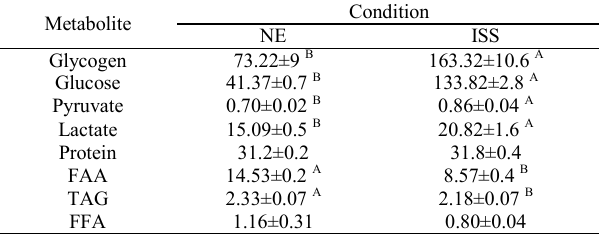
Table 2. Metabolic profile of liver of Brycon amazonicus submitted to ISS. Juvenile ‘matrinxã’ were submitted to intermittent sustained swimming (ISS) at 1.0 Body-Length sec -1 for 30 days. NE - non exercise; ISS - 12/12h (swimming/ still). Glycogen (µmol of glycosyl-glucose (g protein) -1 ); glucose (nmol g -1 ); pyruvate (µmol g -1 ); lactate (µmol g -1 ); protein (mg g -1 ); FAA - free amino acids (µmol g -1 ); TAG - triacylglycerol (mg g -1 ), FFA - free fatty acids (µmol g -1 ); TAG/ FFA ratio. Superscript letters mean significant difference between conditions for the same parameter at